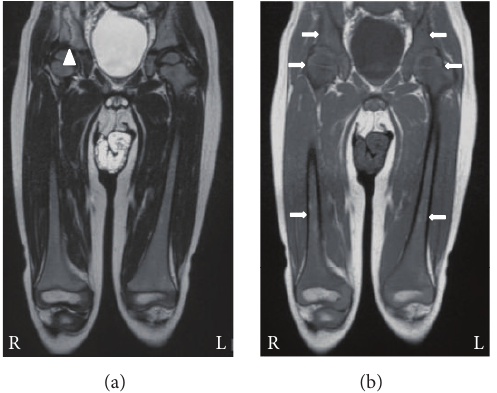
Figure 3: MRI findings in case 3. At 3 days after the onset, (a) T2-weighted image depicts high signal intensity in the right ilium (arrowhead) and (b) T1-weighted images reveal diffuse low signal intensity in the bilateral iliac and femoral bone marrow